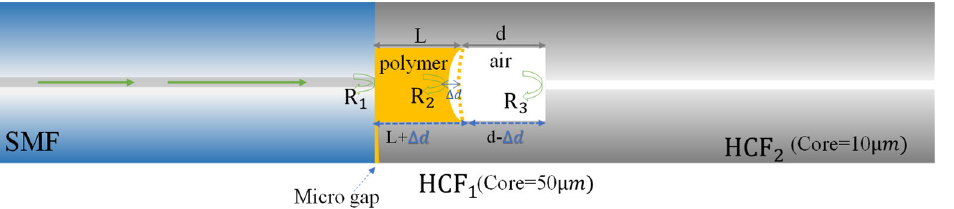
Figure 1. Configuration of the proposed DCFFPI with a dual cavity (polymer and air). Here, R 1 , R 2 , and R 3 denote the Fresnel reflections from the interfaces of the structure.